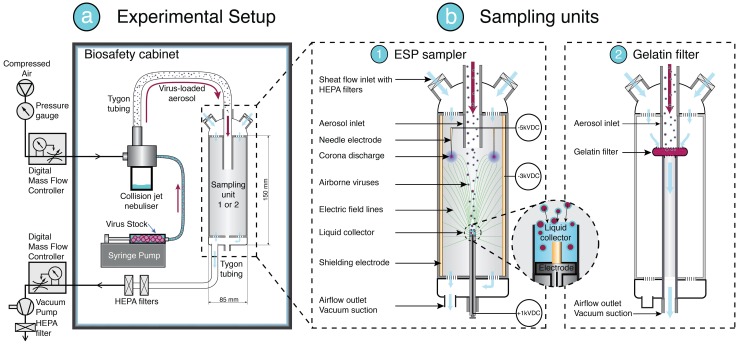
Schematics of the experimental setup (not to scale).(a) Experiments are conducted in a bio-safety cabinet to keep all aerosolized virus contained. The setup includes a Collison nebulizer to aerosolize using compressed air and viral solutions provided by a syringe pump. Tubing directs the airborne viruses into the sampling unit (b): (1) our ESP sampler or (2) gelatin filters for comparison. A downstream vacuum pump maintains a constant flow and under pressure inside the ESP sampler. (b) Details of the sampling units: (1) Our ESP sampler includes a three-electrode corona discharge electrostatic precipitator to capture the aerosol particle directly into an integrated liquid collector with a miniaturized volume of 150 μL; (2) gelatin filters are used for comparative measurement of the total amount of virus effectively entering the ESP sampler after nebulization. The filters are housed in a specific cassette placed at the aerosol inlet.